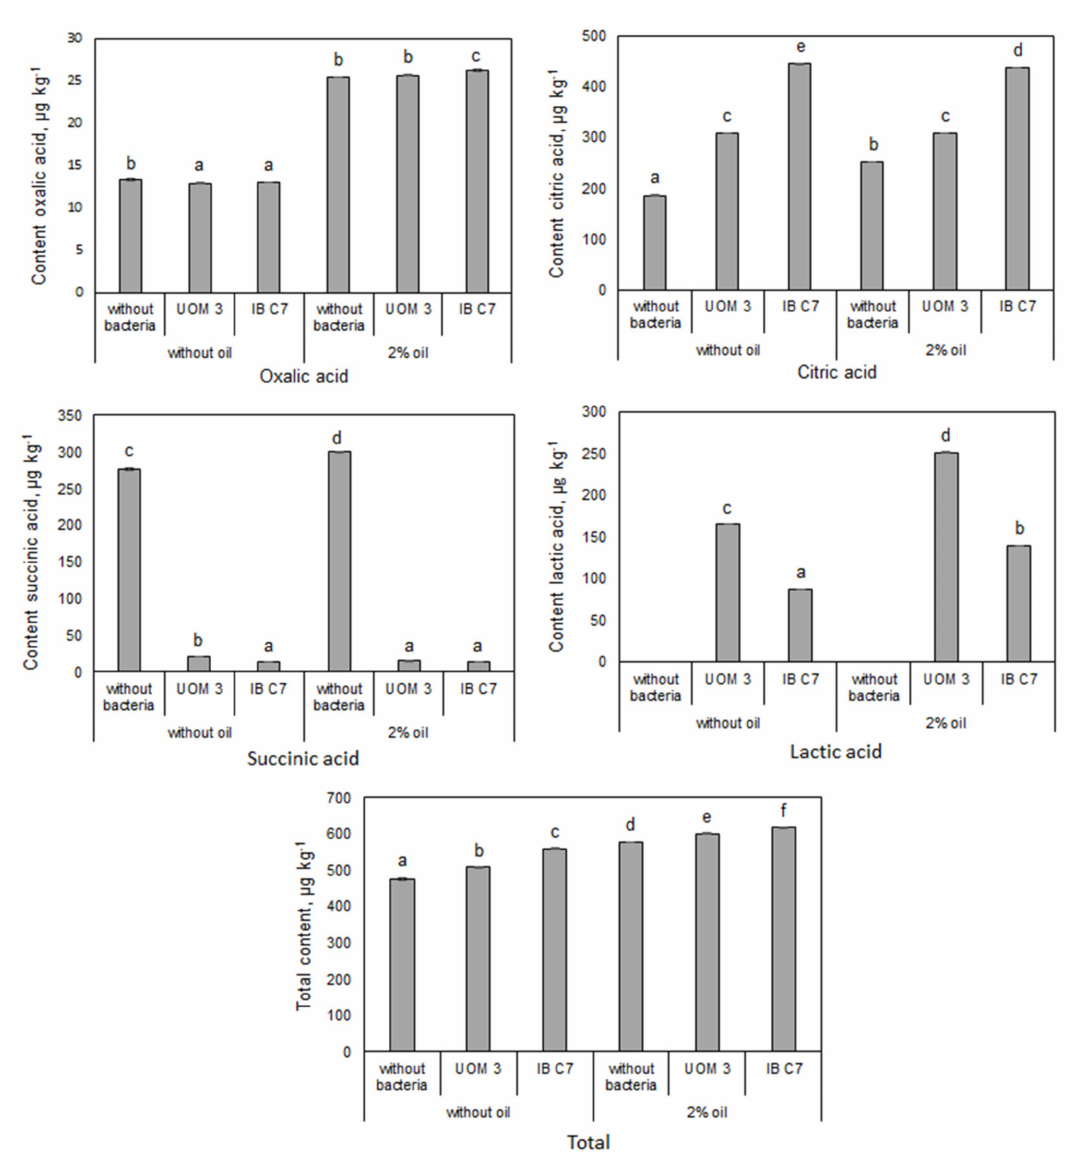
Figure 1. Content of organic acids in pots planted with barley, µ g kg − 1 of sand. UOM 3 and IB C7—treatments with introduction of Enterobacter sp. UOM 3 and P. hunanensis IB C7, respectively. Statistically different means for each organic acid (n = 9) are marked with different letters ( p ≤